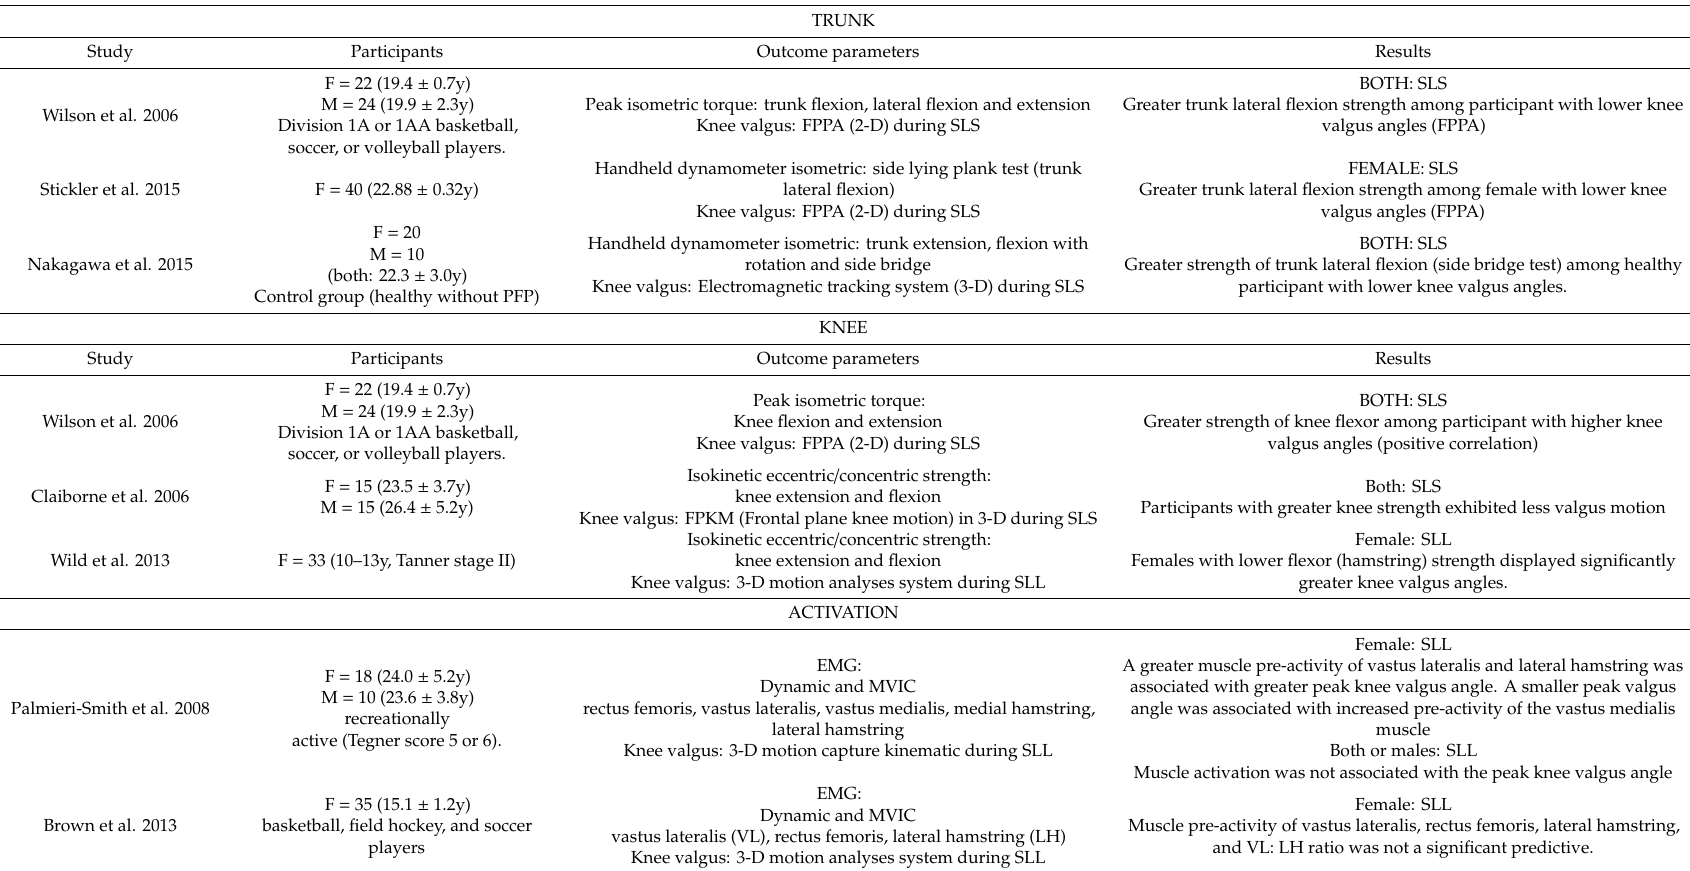
Table 1. Characteristics of studies in causes of dynamic knee valgus